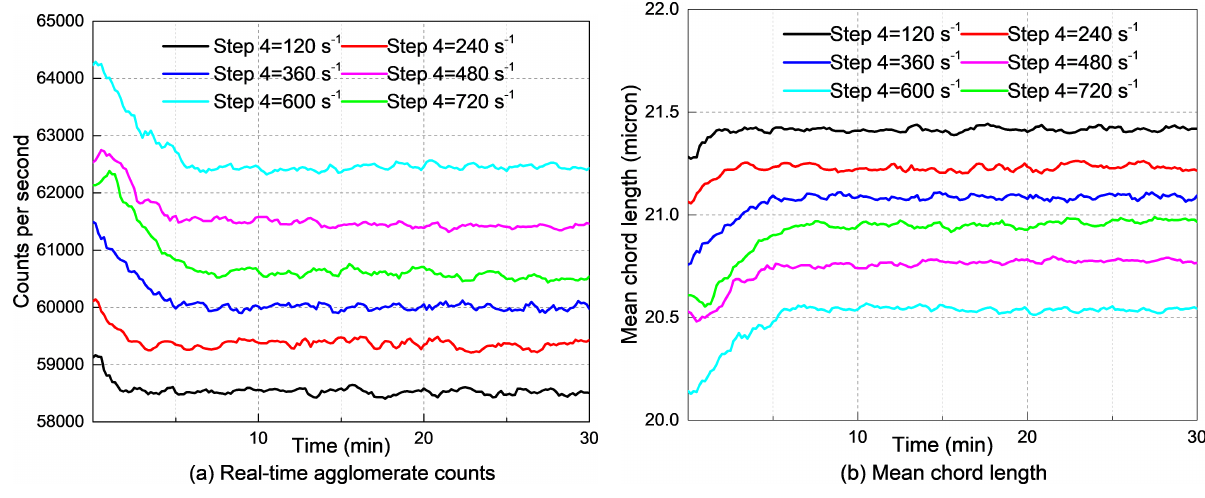
Figure 10: Effect of shear history on fresh state agglomerate condition for CPB-A.